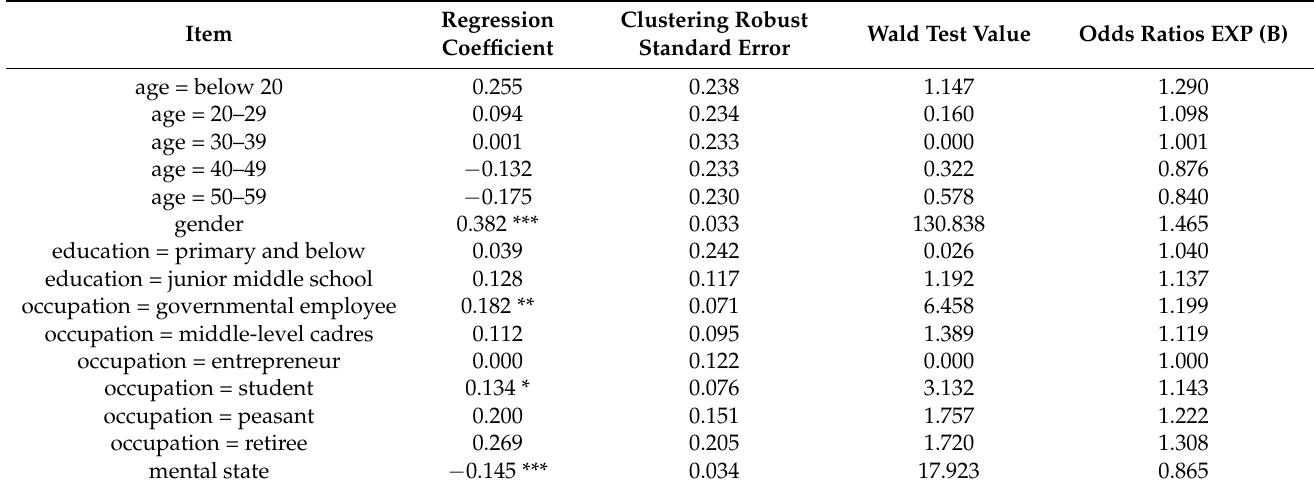
Table 4. Simulation results of public environmental